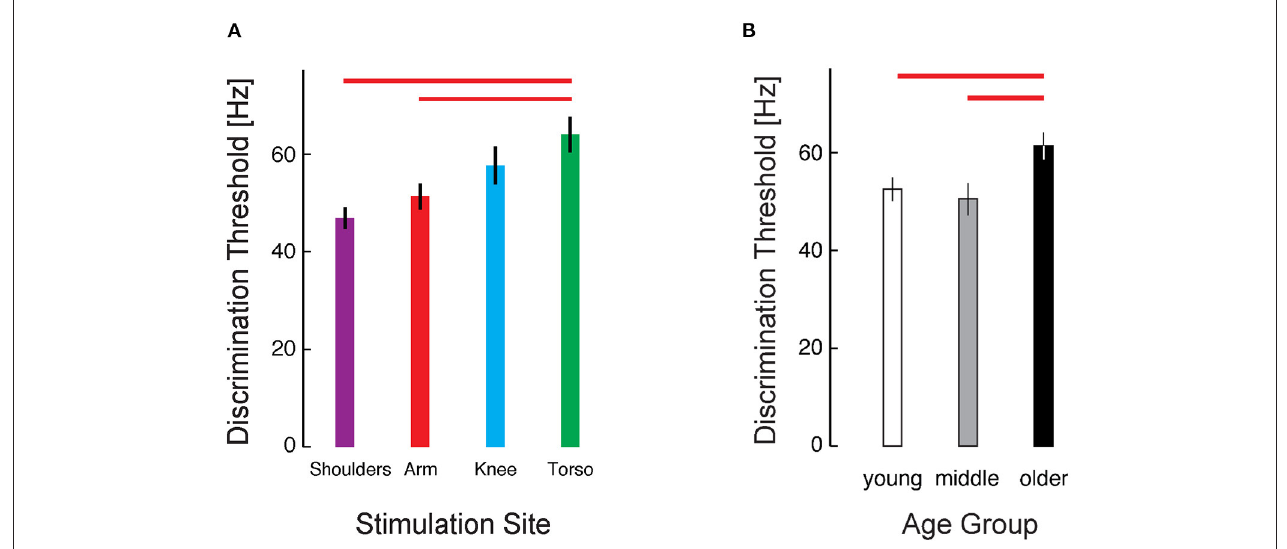
FIGURE 3 | Cohort results from Experiment 1. (A) Average vibrotactile discrimination thresholds (mean bars indicate significant differences between the arm and torso ( p subsequent statistical analysis. Participants performed worse (i.e., they had higher vibrotactile thresholds) when the vibratory stimuli were applied across the torso vs. when they were applied at the other locations. (B) Vibrotactile discrimination thresholds (mean group. Red bars indicate significant differences between the older adult age group and the middle-age ( p that we report vibrotactile stimulus intensity in terms of frequency for narrative simplicity even though vibration amplitude covaries with frequency in the ERM